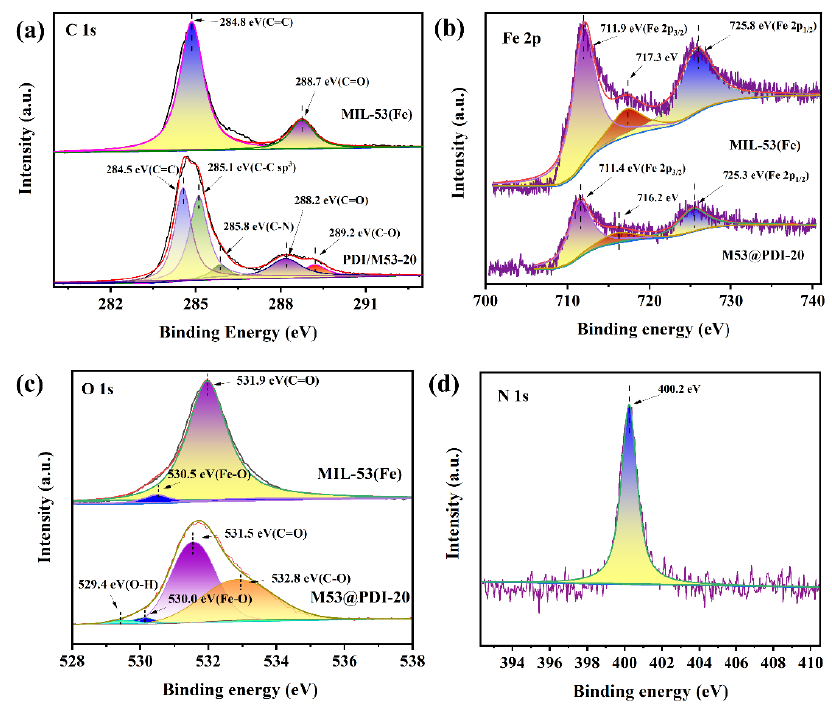
Figure 2. XPS spectra of MIL-53(Fe) and M53@PDI-20: ( a ) C 1s; ( b ) Fe 2p; ( c ) O 1s; ( d ) N 1s.